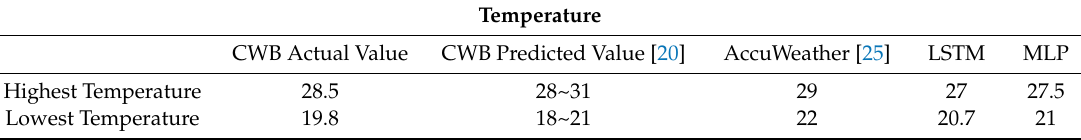
Table 13. Comparison of the highest and lowest temperatures on 21 March 2020 (unit: ◦